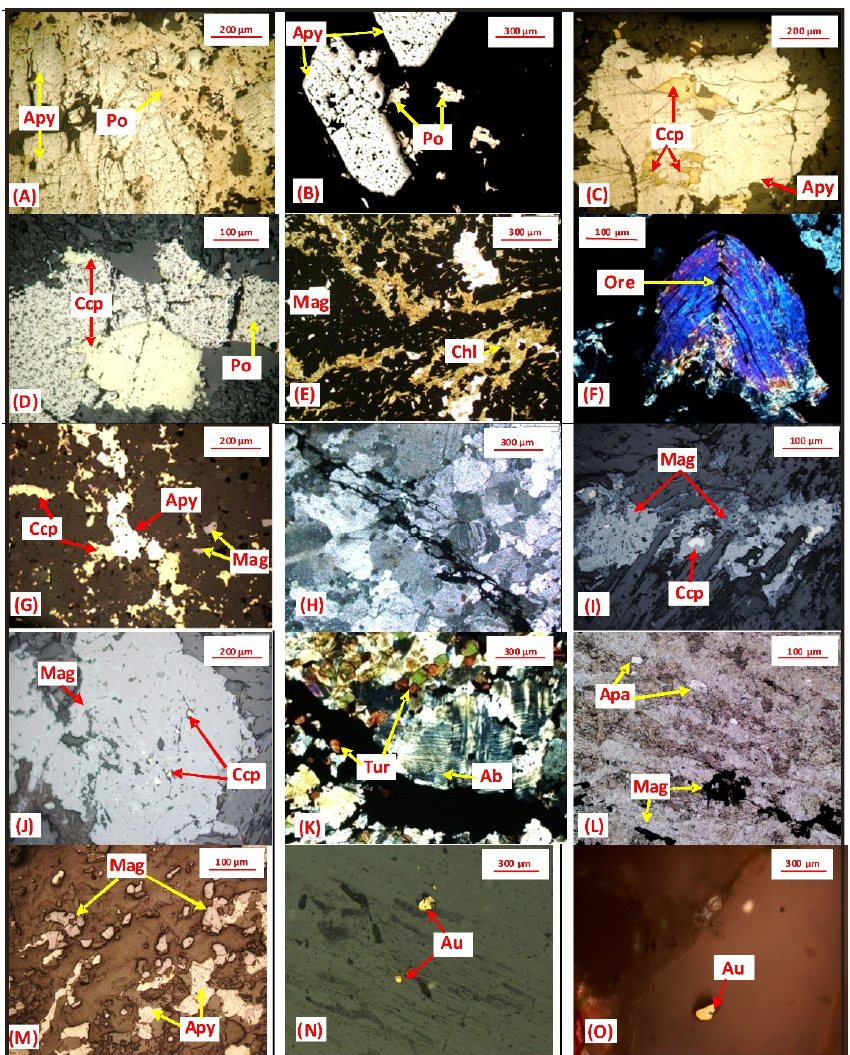
Figure 7. Photomicrograph showing various generations of mineral assemblages such as magnetite- apatite-sulfides-gold and their linkages to the shear zone characteristics and deformation patterns. ( A ) Catascatically deformed arsenopyrite of the first generation, where fractures are healed by pyrrhotite; ( B ) Undeformed isomorphic, euhedral, rhombic shaped second generation arsenopyrite; ( C ) Fractures of arsenopyrite are healed by later formed chalcopyrite; ( D ) Convexity of chalcopyrite grain in pyrrhotite indicate that pyrrhotite has formed earlier; ( E ) Occurrence of abundant subhedral magnetite grains within quartz-mica schist; ( F ) Saddle reef structure having sulfide mineralization at the hinge of microfold indicating ore remobilization; ( G ) Disseminations of arsenopyrite, pyrrhotite, chalcopyrite and magnetite of early stage mineralization; ( H ) Nature of mineralized shear system showing shear planes cross cutting the albite grains; ( I ) Magnetite vein of second stage mineralization, occurring parallel to shear fracture; ( J ) Coarse grained magnetite with associated chalcopyrite; ( K ) De- formed albite twin lamellae in albitite close to mineralized vein; ( L ) Occurrence of subhedral apatite grains associated with magnetite in quartz-mica schist; ( M ) Disseminated magnetite and arsenopyrite of early stage mineralization; ( N ) Native gold grains in quartz-mica schist; ( O ) Skeletal gold speck in second generation quartz vein intrusive within quartz-mica schist. (Apa = apatite, Mag = magnetite, Apy = arsenopyrite, Po = pyrrhotite, Ccp = chalcopyrite, Au = gold, Tur = tourmaline, Ab = albite, Chl =